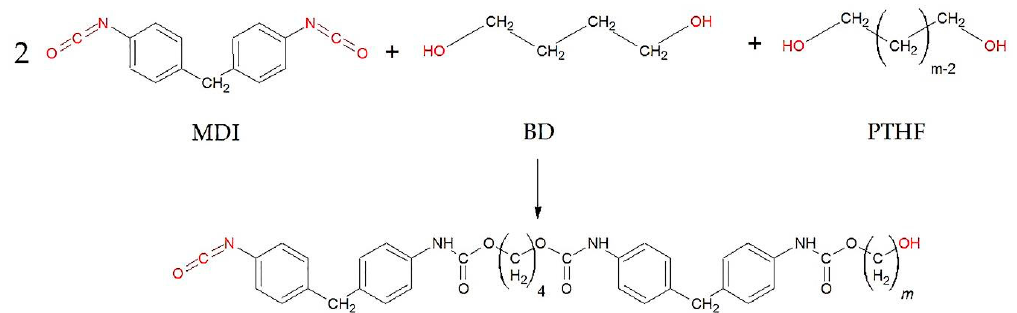
Figure 1. The reaction scheme of the synthesis of thermoplastic